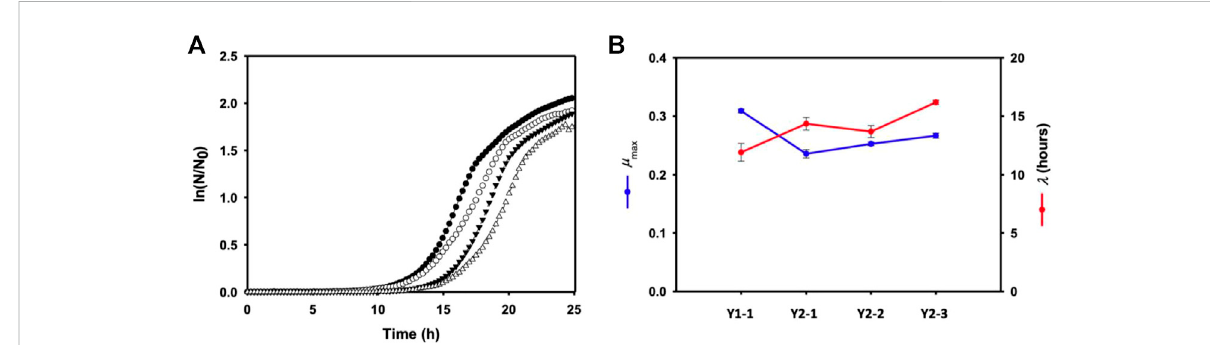
FIGURE 4 (A) Cell growth of each mutant (closed circular: Y1-1, open circular: Y2-1, closed inverted triangle: Y1-1, and open inverted trianlge: Y2-3) in a yeast extract-peptone medium containing 10 g/L yeast extract and 20 g/L Bacto-peptone in sterile 24-well PS plates. (B) the maximum speci fi c growth rate( μ max)andlag time( λ )ofeachmutantcalculatedbytheGompertzmodel.Errorbarsrepresentthestandarderrorofthemeanofatleast three independent replicates.